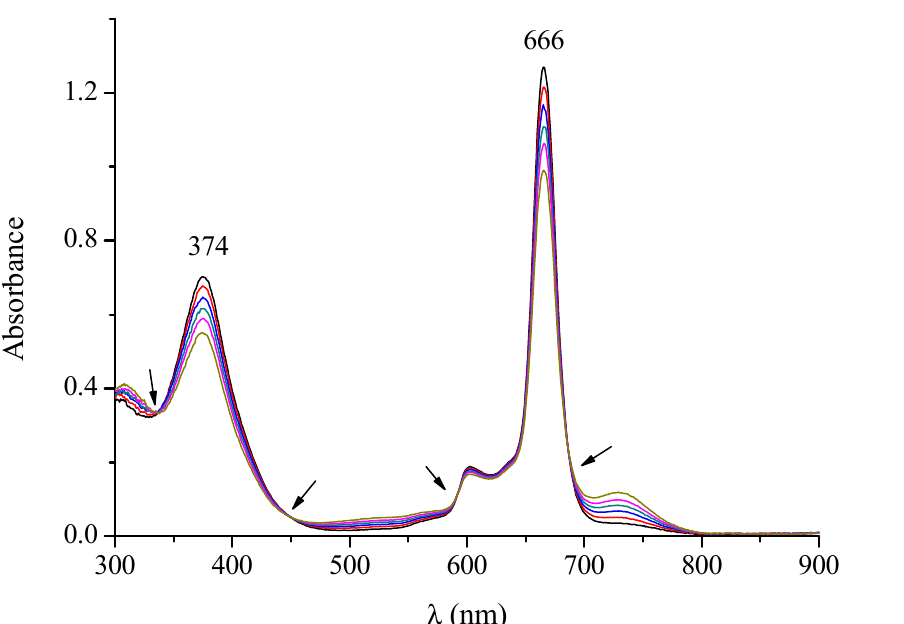
Figure 7. UV-visible spectral behavior in DMF of the complex [Py 8 TPyzPzIn(OAc)] · 8H 2 O in the range 300–900 nm (arrows indicate isosbestic positions ).